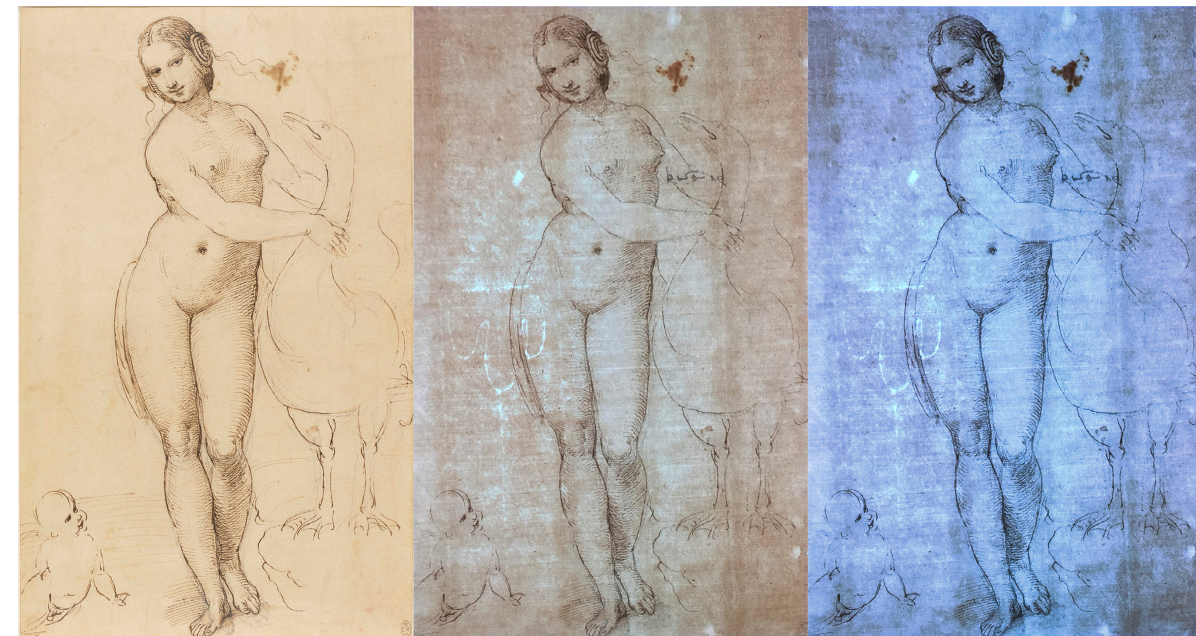
Figure 3. Raphael, Leda and the Swan , ca. 1507, pen and ink over black chalk underdrawing, 210 × 192 mm, RCIN 912759, Royal Collection, Windsor Castle. Royal Collection Trust/© Her Majesty Queen Elizabeth II 2021. Detail of the diagnostic tests and virtual reconstructions on the drawing Leda and the Swan by Raphael (RCIN 912759). On the left, the sheet in diffuse (standard) light conditions; in the centre the sheet in transmitted light; on the right the sheet in transmitted light with a colour level on blue hues to achieve a higher contrast of the lines of the paper mould. Used with permission. Image in transmitted light created by